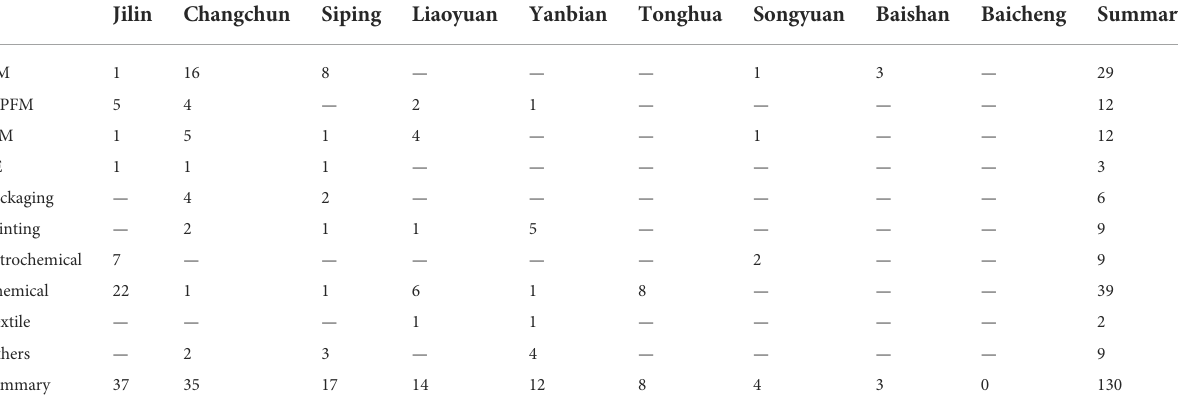
TABLE 1 Number of VOCs emission-related legal entities in various industries registered in Jilin